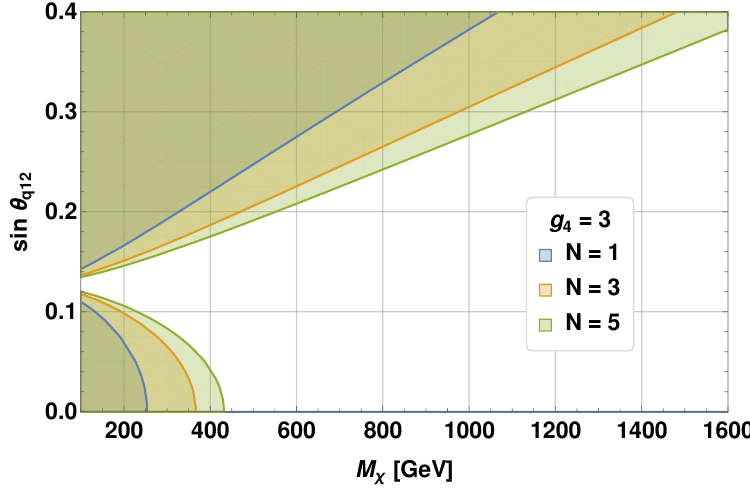
Figure 7 . DM constraints in the M (cid:31) vs. sin (cid:18) q regions excluded by Xenon1T